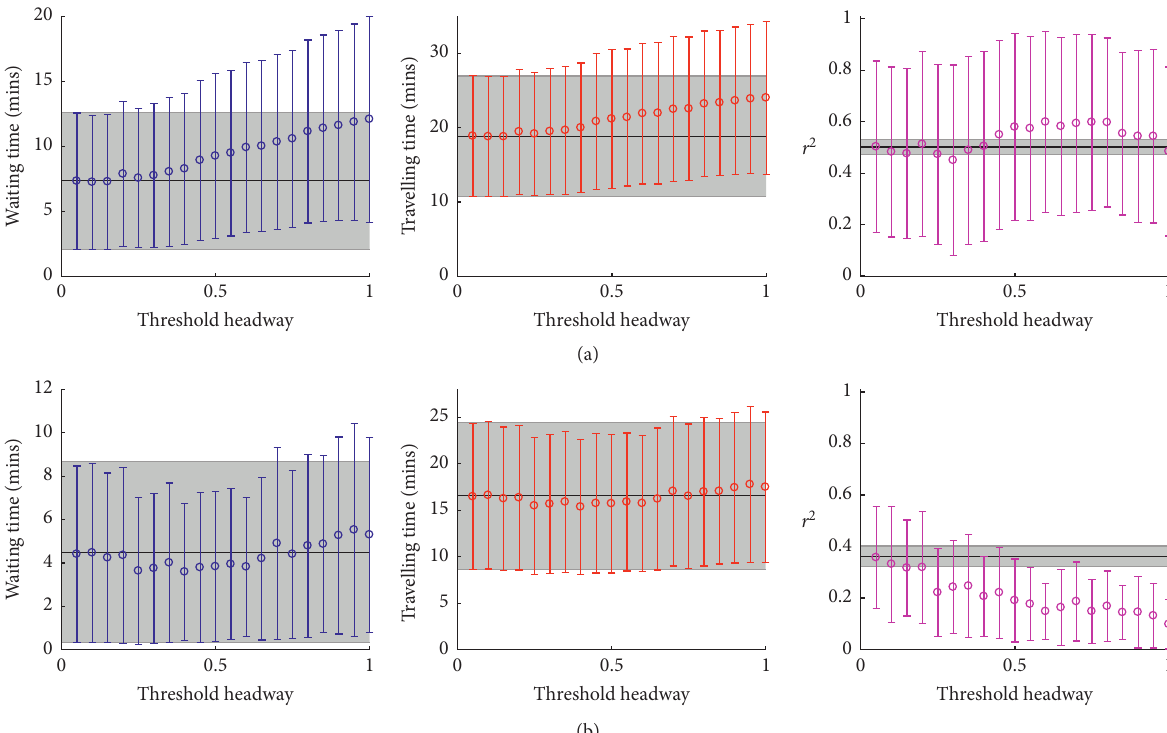
Figure 13: Results of the no-boarding strategy in the two different-velocity scenarios. Each colored point represents the mean and standard deviation of the measured quantities calculated from 100 realizations of each parameter value. The black line and grey shaded area of each graph denote the mean and standard deviation of the measured quantities from a control case, which are simulation runs of the same parameter values, without any intervention strategies. (a) Distance-based no-boarding strategy in lull-different. (b) Distance-based no- boarding strategy in